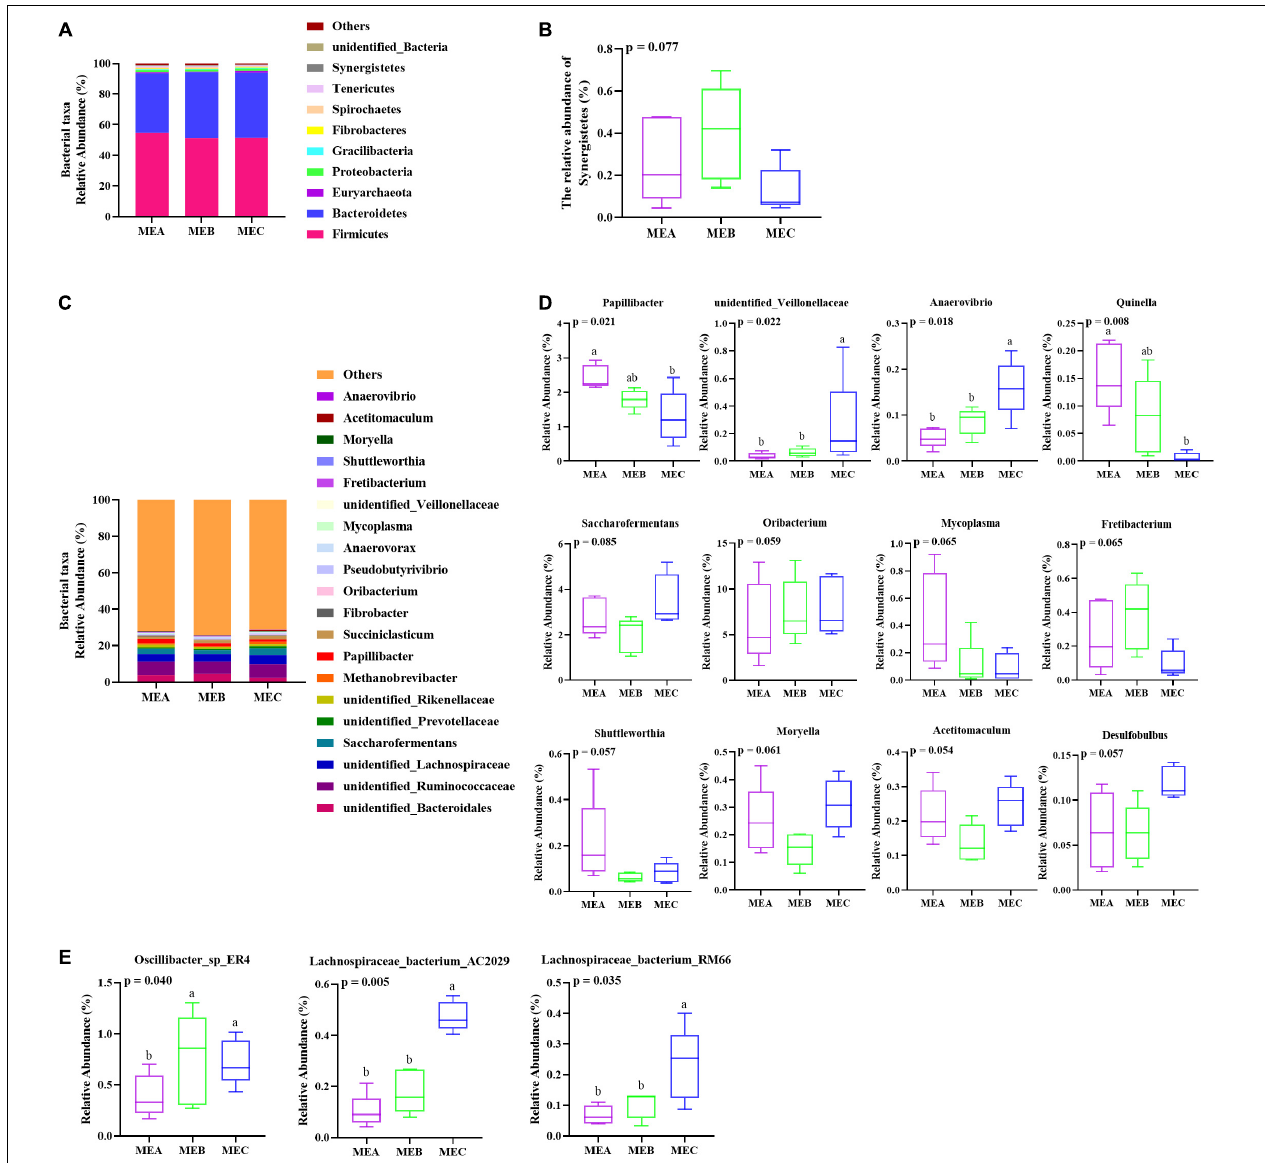
FIGURE 2 | Effects of low-, medium-, and high-energy diets on rumen microbiota in male Hu lambs. (A) Bacterial taxonomic profile of the rumen microbiota at the phylum level. (B) Relative abundances of Synergistetes . (C) Relative abundances of the dominant genera in the rumen. (D) Relative abundance of representative genera. (E) Relative abundance of representative species. Values with different superscripts (a,b) differ significantly at p < 0.05.